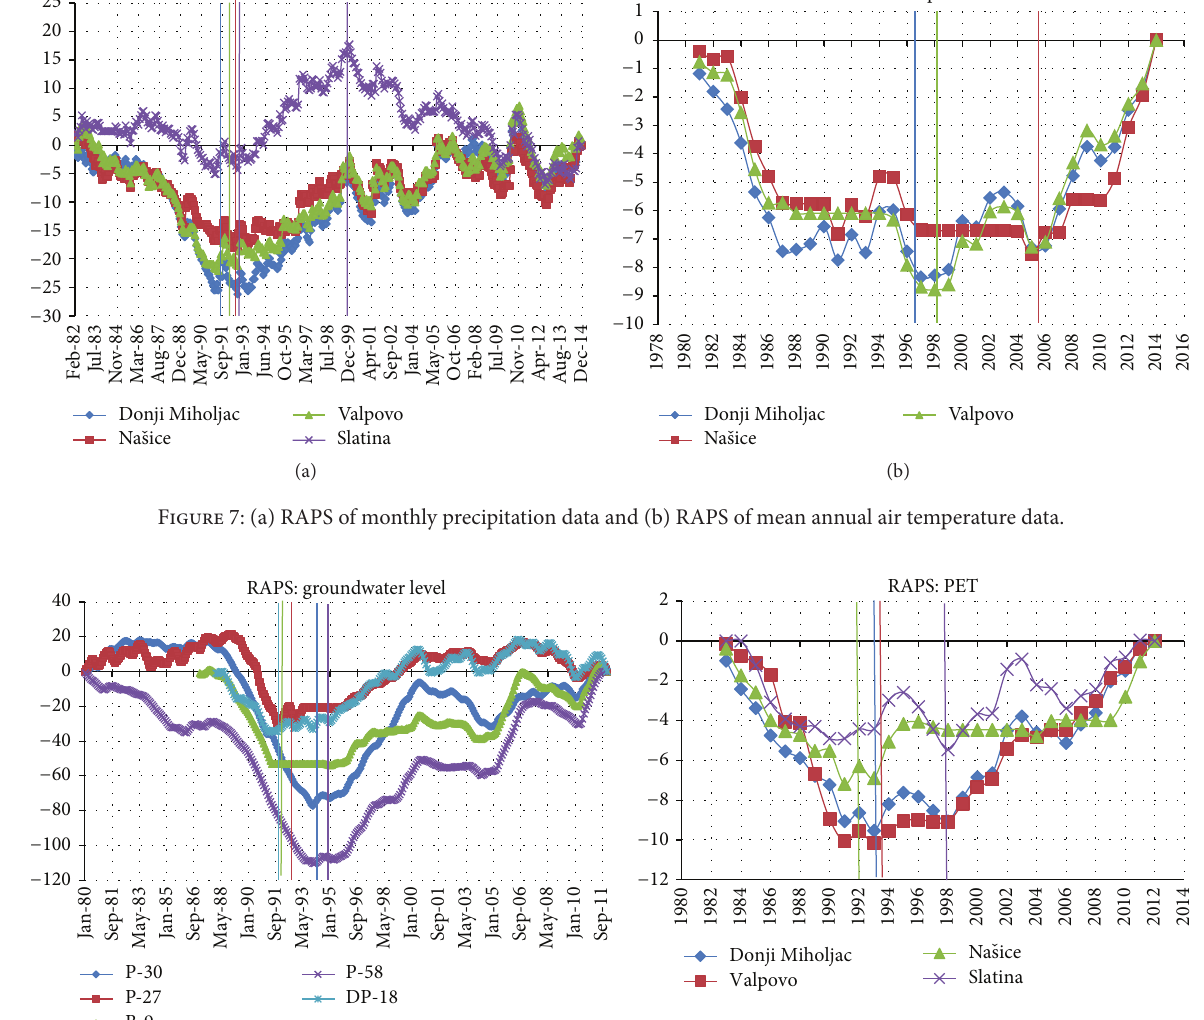
Results obtained in this research confirm previous state- ment, but subperiods of decreasing and increasing discharges have a delay of 4-5 years comparing to the precipitation, and the coefficients of variations are not